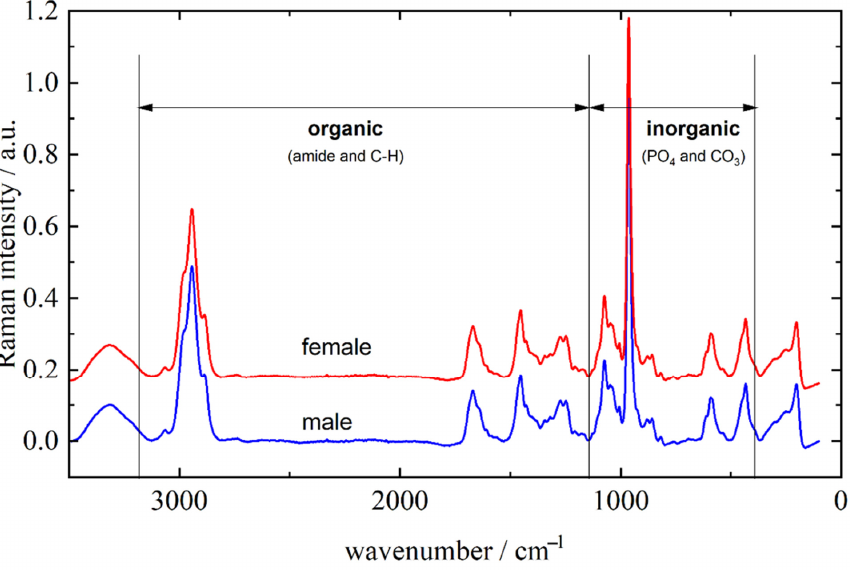
Figure 1. Representative Raman spectra of male and female molar teeth recorded from apex in the 3500–200 cm − 1 range. The spectra are offset along the y -axis for clarity. Later in this article, after application of statistical methods, it will be shown that there exist small differences in inorganic/organic ratio of the several vibrational bands. These properties reflect the fact that the two observed types of tooth tissue are built from the same molecules but in different relative amounts. The major component of the inorganic part is carbonated calcium-deficient hydroxyapatite, while most of the organic part con- sists of collagen [28,29]. Assignation of the relevant vibrational bands is listed in Table 1. Table 1. Assignment of major bands found in Raman spectra of teeth [27,30,31].